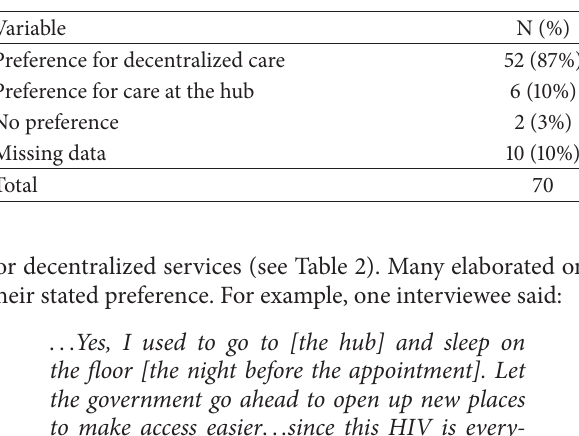
Table 2: Preferences for hub versus decentralized care expressed by patient participants in individual